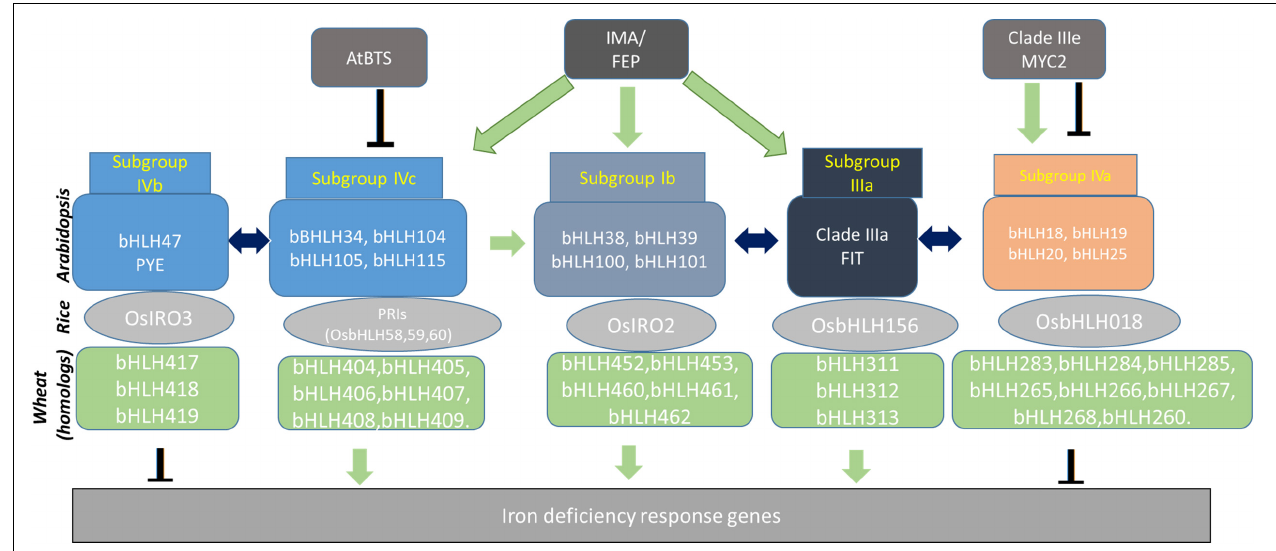
FIGURE 2 | Transcriptional homologs of Arabidopsis and rice bHLH proteins reported for their functional activity for Fe homeostasis. The respective homologs from wheat were identified and placed in the network as a probable candidate for function. Their conserved role in Fe-related phenomenon remains to be tested and validated. Many of these bHLH transcription factors are in turn regulated by BRUTUS, IRON MAN: IMA, and bHLH-like MYC2. Schematic arrangement of bHLH dependent interaction and control at the transcription level is indicated by respective arrow signs: Green arrow: transcriptional activation; Inverted T: gene repression; Both side arrow: protein-protein interaction.